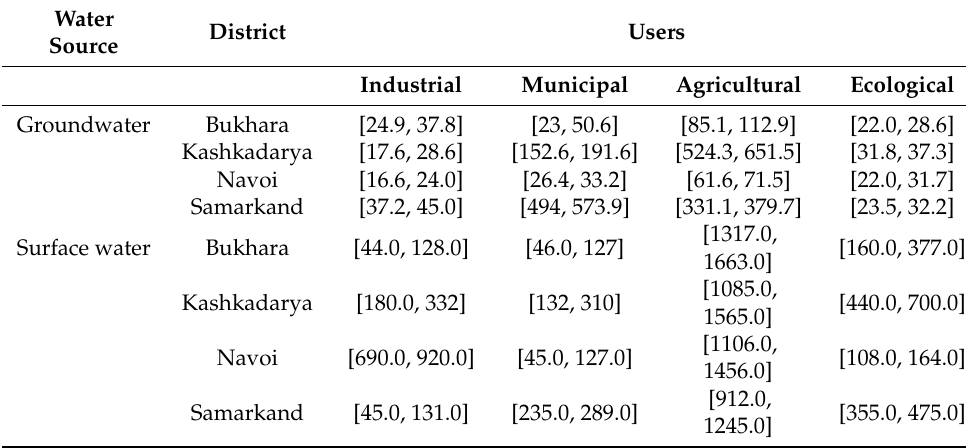
Table 3. Water-allocation target for different users (10 6 m 3 ).